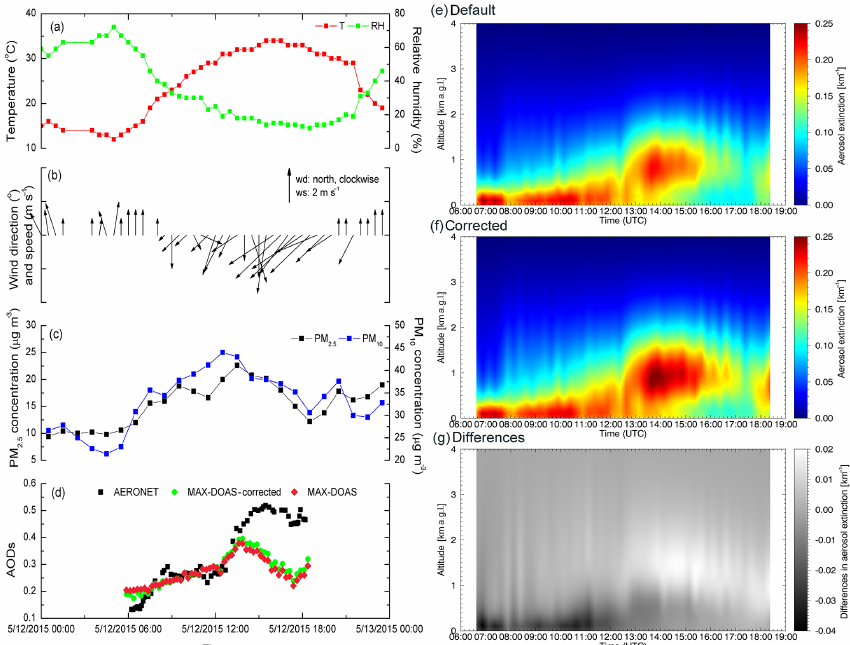
Figure 8. Diurnal variation of meteorological parameters (a) and (b) , in situ particle concentrations (c) and MAX-DOAS-retrieved AOD (d) and aerosol extinction profiles for a dust intrusion case study on 12 May 2015. Aerosol extinction profiles with default setting and corrected with AERONET products are shown in (e) and (f) , respectively. (g) shows the difference of aerosol extinction between (e) and (f) (corrected –